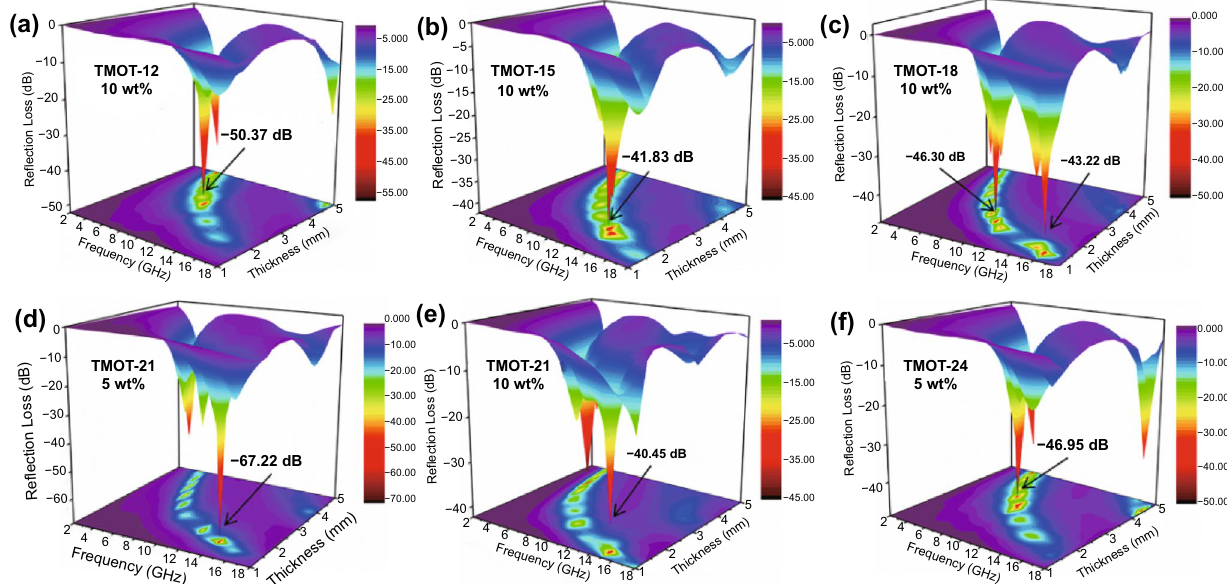
Fig. 8 3D plots of RL values for various TMOT‑x